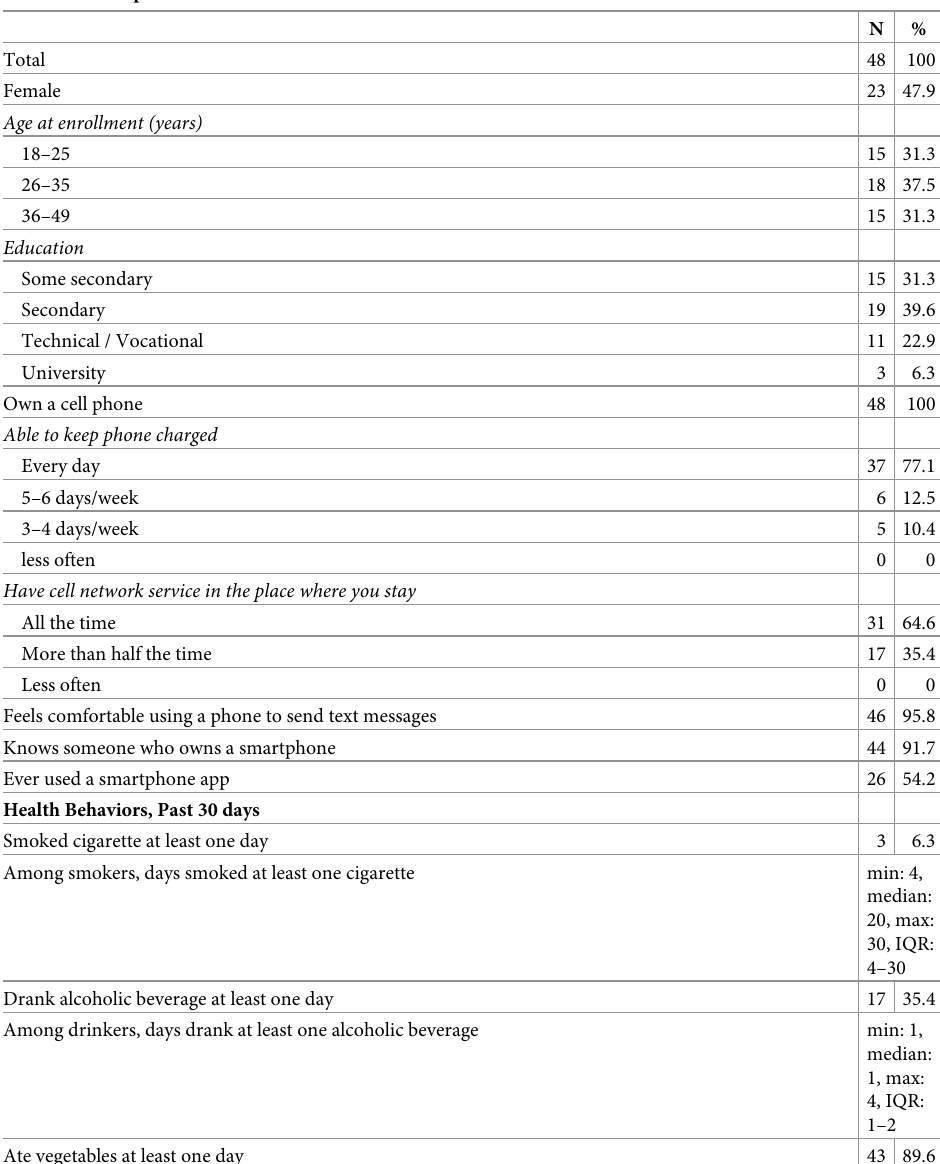
Table 1. Participant characteristics at